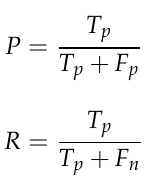
Figure 11. Failure cases: (1) input images, (2) ground truth, (3) saliency map, (4) saliency object segmentation using the proposed method.